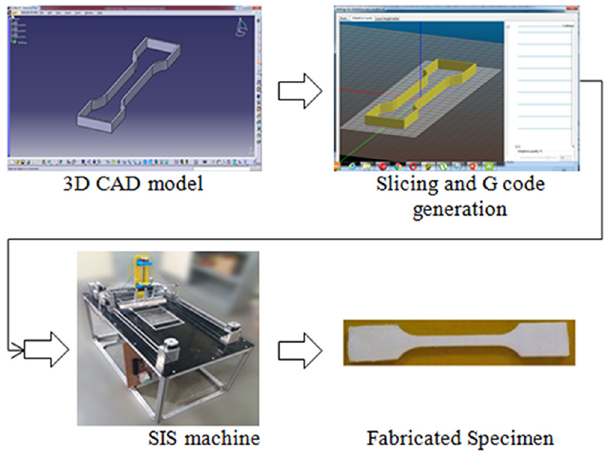
Fig. 2. SIS part fabrication procedure.